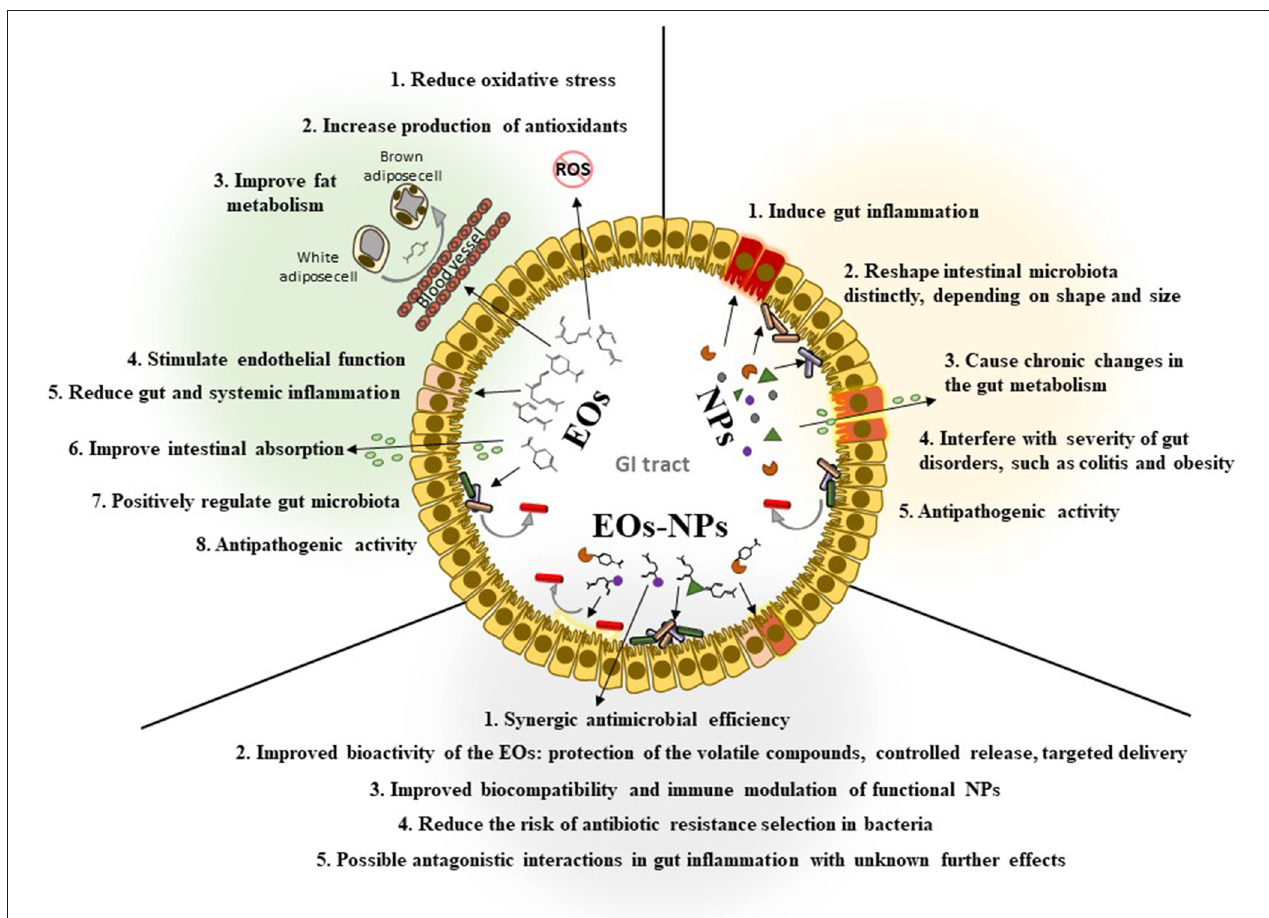
FIGURE 1 | Scheme revealing the main mechanisms which may be modulated by EOs, NPs, and their association in the